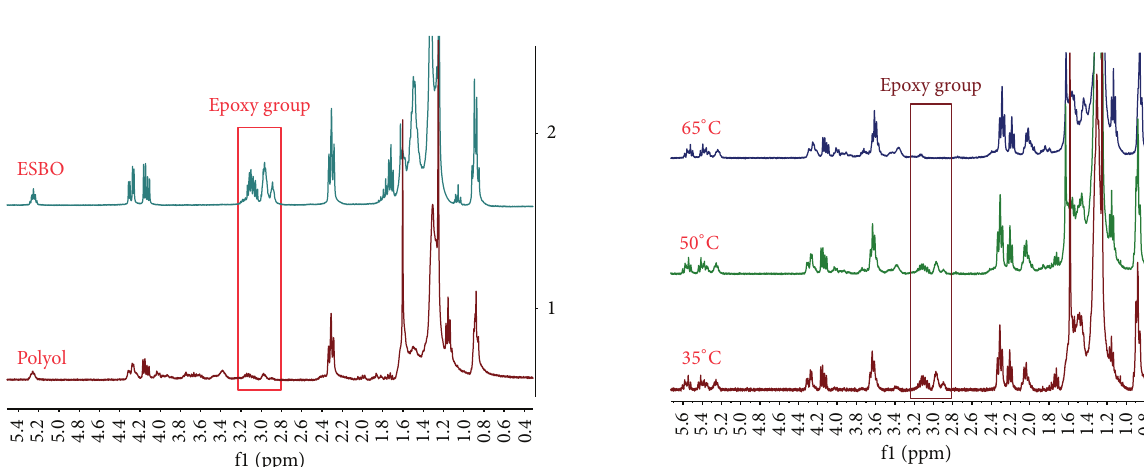
Figure 9: Rheological behaviors of polyols with different reaction time.